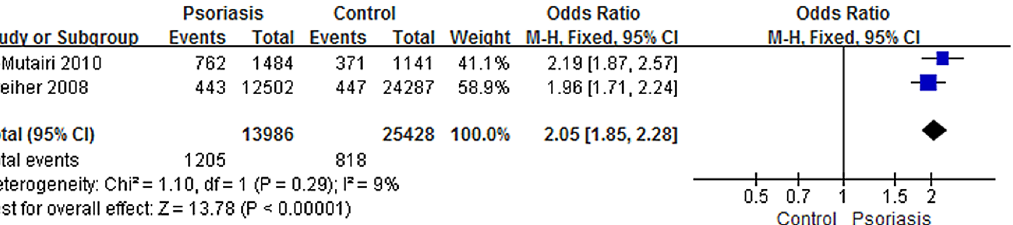
Fig 4. Meta-analysis of psoriasis and prevalence of current smoking compared with controls. “ Events ” means the number of current smoking in subjects. Odds ratios (ORs) for current smoking in subjects with psoriasis compared with subjects without psoriasis. The point estimate (center of each blue square) and the statistical size (proportional area of the square) are shown. Horizontal lines indicate 95% confidence intervals. The pooled OR (diamond) was calculated using a fixed-effects model.